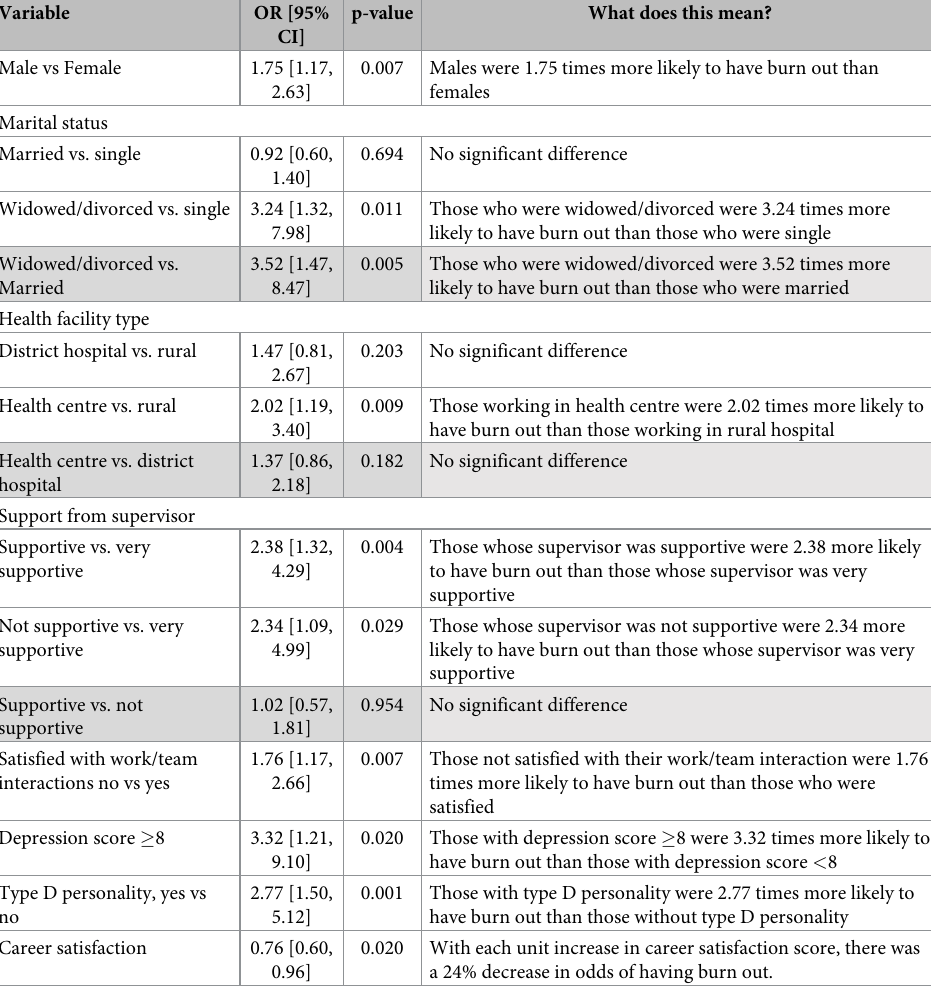
Table 2. Final multivariable logistic regression model of factors associated with